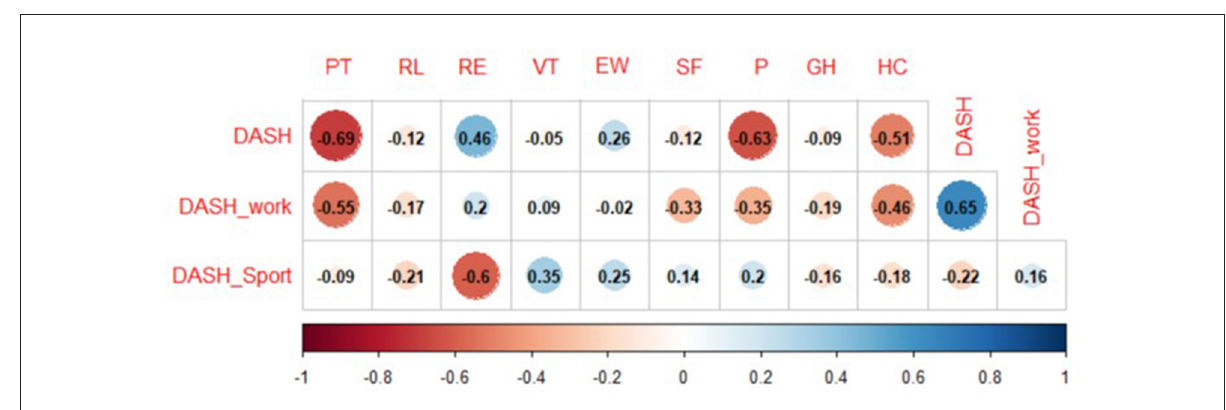
FIGURE4 Correlations between subjective outcome measures. DASH, Disability of Arm, Shoulder and Hand; PF, physical functioning; RP, role-physical; RE, role-emotional; VT, vitality; EW, emotional well-being; SF, social functioning; P, pain; GH, general health; HC, health